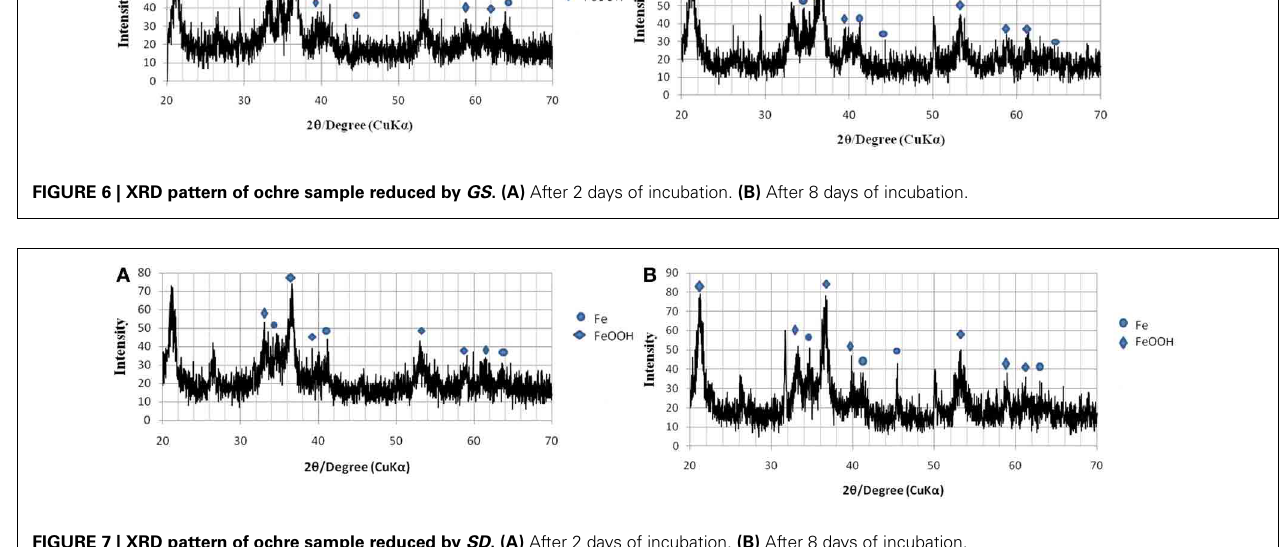
FIGURE 7 | XRD pattern of ochre sample reduced by SD . (A) After 2 days of incubation. (B) After 8 days of incubation.